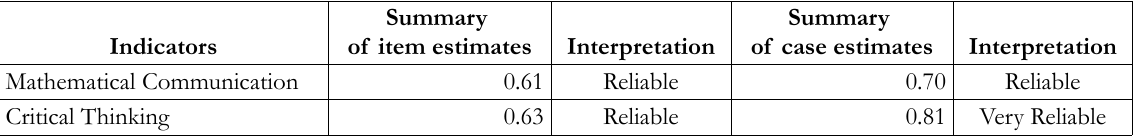
Table 5. Results of the analysis of the